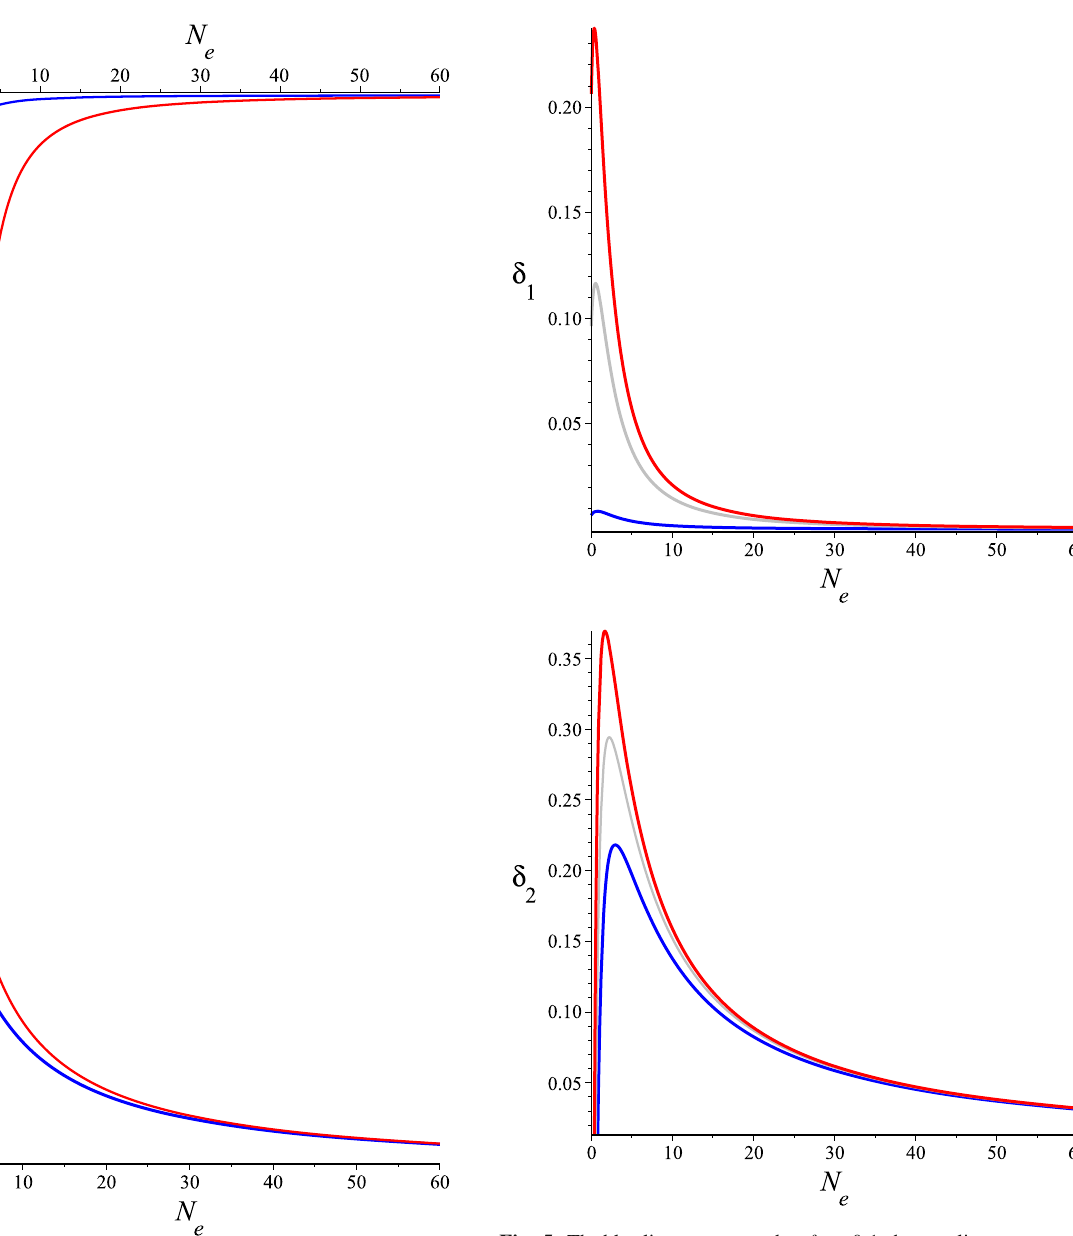
Fig. 5 Thebluelinescorrespondto f 0 = 0 . 1,thegreylinescorrespond to f 0 = 2, and the red lines correspond to f 0 = 8. The parameters δ 1 and δ 2 are presented at K = K